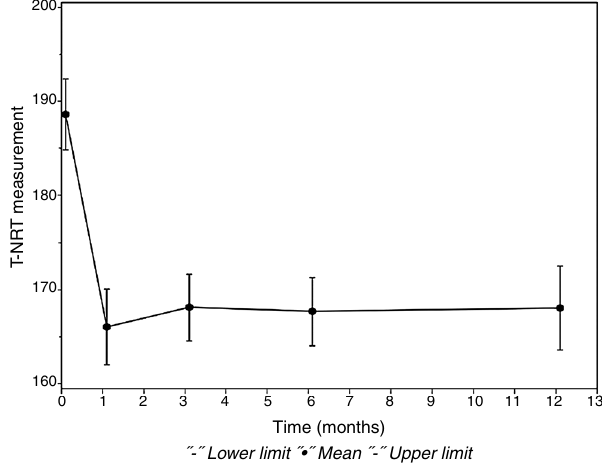
Difference in T-NRT (current units) between the intraoperative and the postoperative follow-up periods. multiple comparisons two by two between the levels of each electrode at each time, with Bonferroni correction.